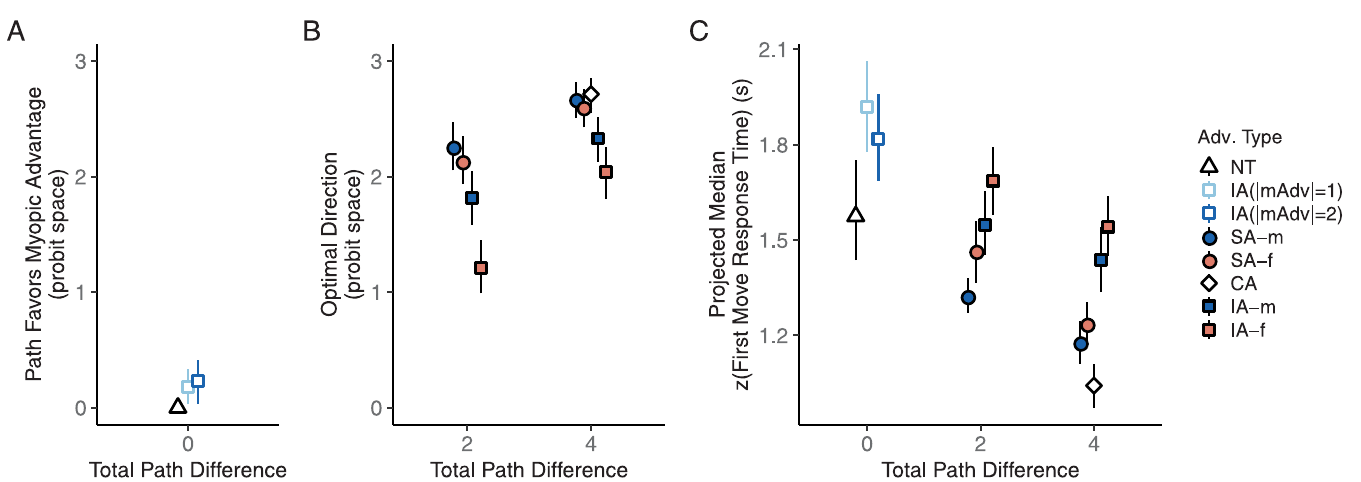
Fig 3. Initial path choices and the associated response times reflected joint consideration of myopic and future constraints. A. Path choices in trials with equally optimal initial directions. The value for NT trials was defined to be 0 since there was neither a myopic nor a future advantage on these trials. B. Path choices in trials where one of the initial directions was optimal. The proportion of optimal trials for each individual was converted into a probit score. If the individual probit score was larger than 3 or smaller than -3, it was capped at 3 or -3 before averaging. C. Response times associated with the first step. The individual medians of zscored response times were projected back to the raw time scale in seconds using group average mean response times and group average standard deviations. Trial advantage types: NT = neutral advantage, SA = single advantage, CA = congruent advantage, IA = incongruent advantage. mAdv = myopic advantage. -m and -f indicates the larger advantage. Error bars indicate bootstrapped 95% confidence